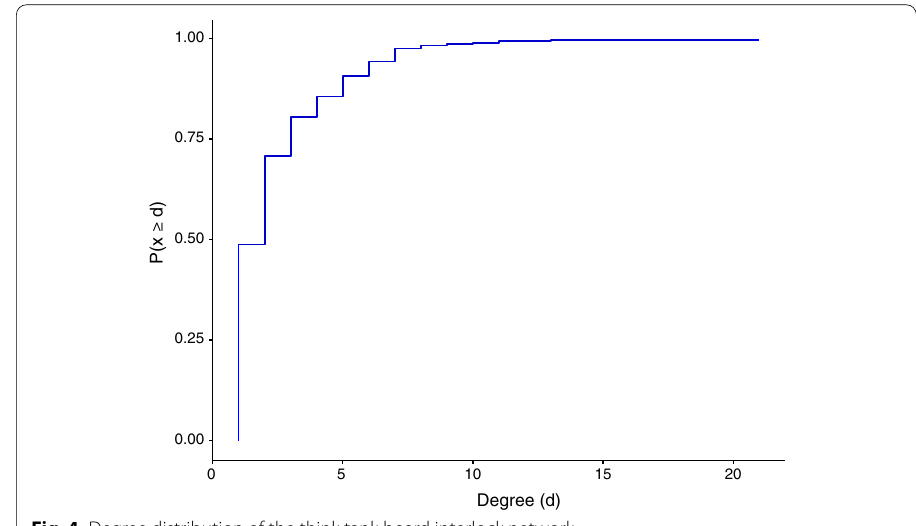
Fig. 4 Degree distribution of the think tank board interlock network